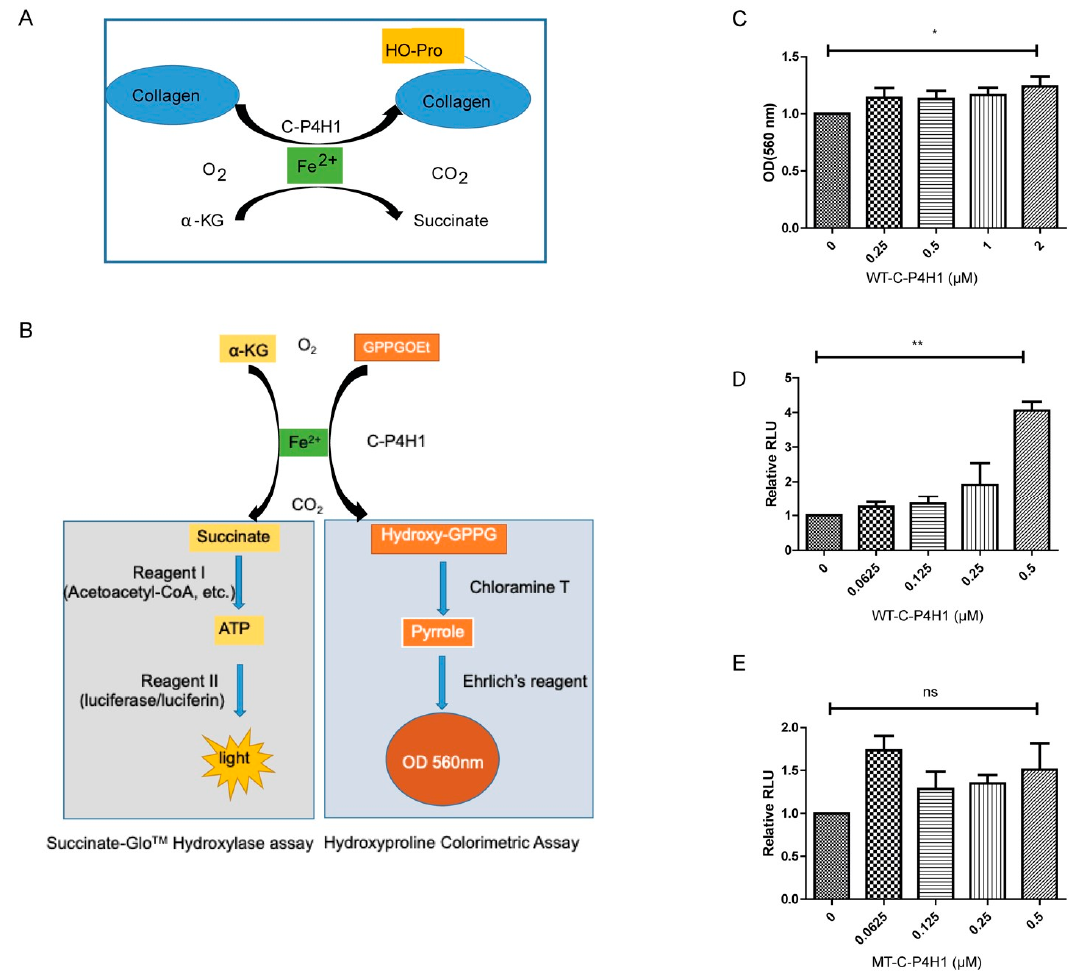
Figure 2. Hydroxyproline Colorimetric Assay and Succinate-GloTM Hydroxylase assay are developed to analyze C-P4H1 activity. ( A ) A scheme showing collagen hydroxyproline reaction. ( B ) A scheme showed how the Succinate-GloTM Hydroxylase assay (Left) which was developed to detect succinate, and how Hydroxyproline Colorimetric Assay (Right) was used to detect the HO-GPPG. ( C ) C-P4H1 activity was evaluated with the Hydroxyproline Colorimetric Assay at different concentrations. n = 3. * p value < 0.05; one-way ANOVA analysis. ( D ) C-P4H1 activity was measured with the Succinate-GloTM Hydroxylase assay at different concentration of protein. n = 3. ** p value < 0.01. One-way ANOVA analysis. ( E ) MT-P4HA1 activity was evaluated with the Succinate-GloTM Hydroxylase assay at different concentrations. n = 3. ns, no statistical significance. The data displayed as means ± standard deviation (SD).